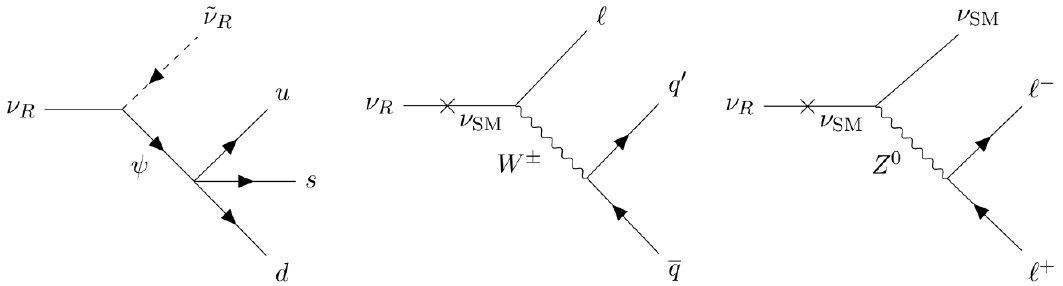
Figure 6. Decays of the right-handed neutrino through an RPV coupling (left) and charged (center) and neutral (center) current interactions after a Dirac mass insertion. Propagator arrows indicate the (cid:13)ow of baryon